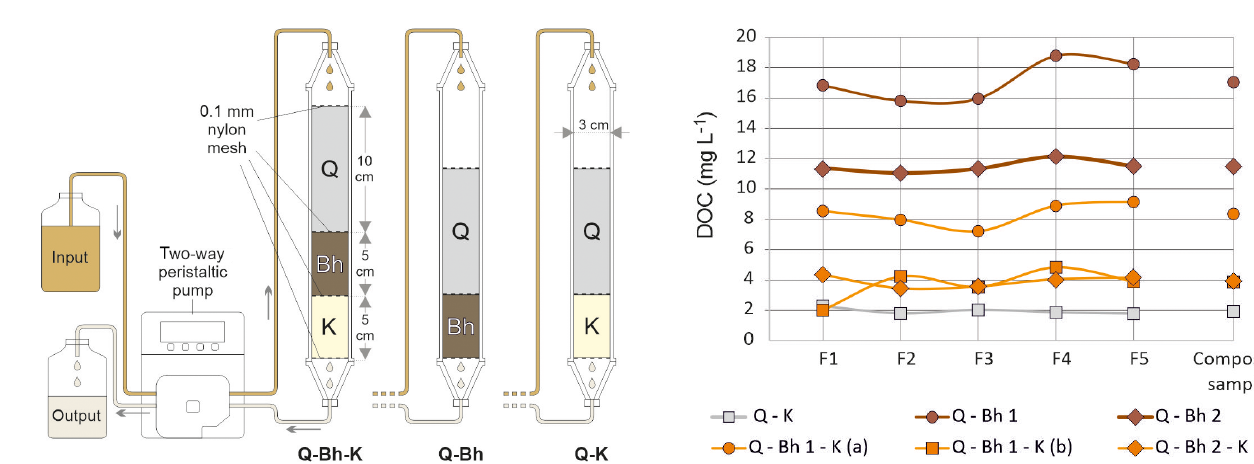
Figure 1. Experimental setup. Q – quartz sand; Bh – sandy Bh ma- terial; K – clayey kaolinitic material.